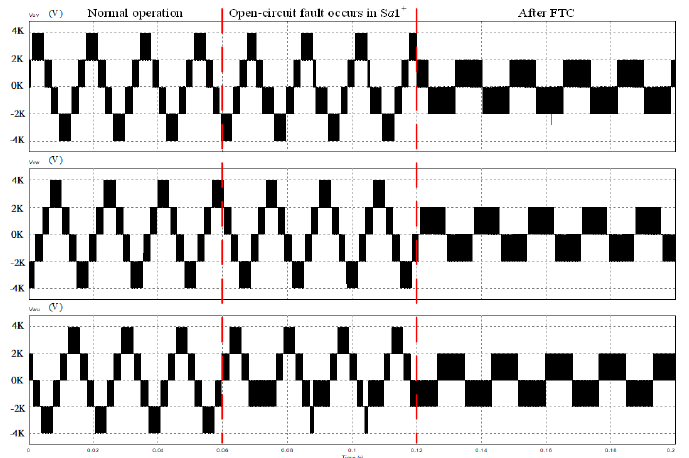
Figure 19. Output voltage with an open-circuit fault in S a1 + after FTC.